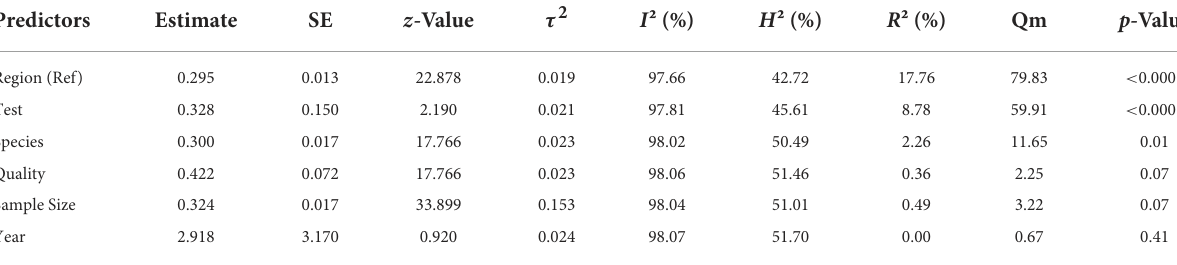
TABLE 2 Table showing the Unitarians meta-regression analysis of Brucellosis in livestock. Predictors